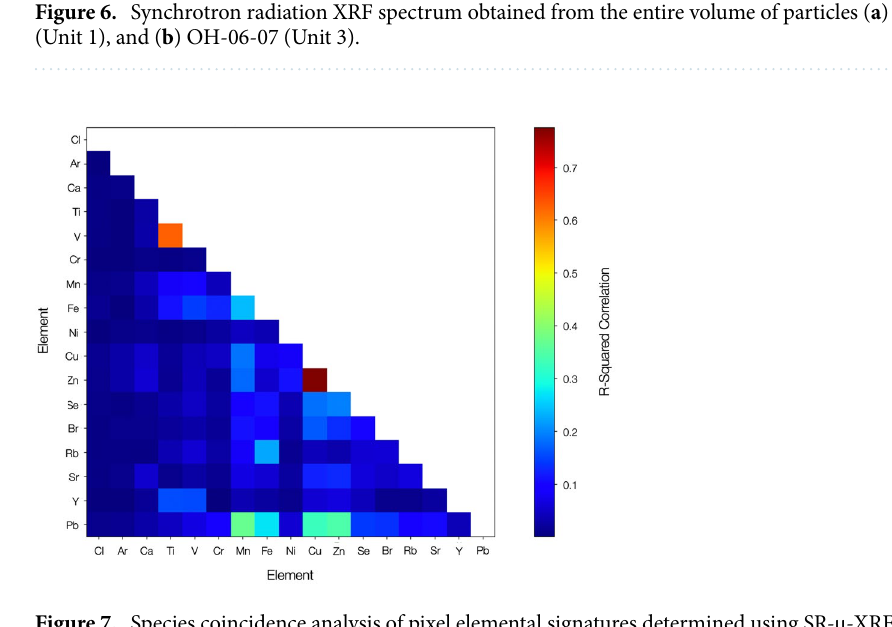
Figure 7. Species coincidence analysis of pixel elemental signatures determined using SR-µ-XRF mapping of the Unit 3 derived, OH-06-07,